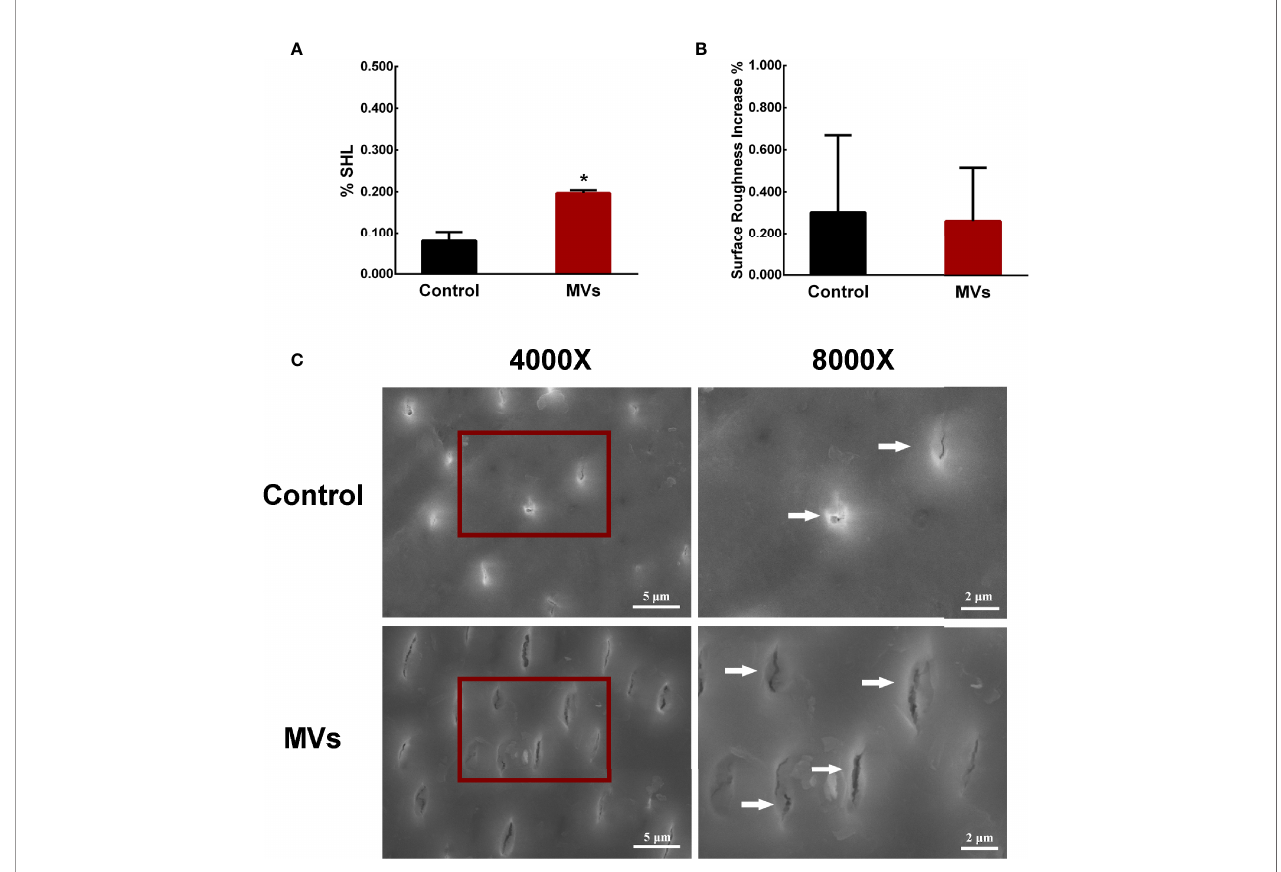
FIGURE 2 | S. mutans MVs promote C. albicans bio fi lm formation to induce bovine dentin demineralization. (A) Dentine surface hardness loss (%SHL) (n = 8). (B) Dentine surface roughness increase (n = 8). (C) SEM images of dentin surfaces. Each fi eld of view was magni fi ed 4,000× and 8,000×. The red boxes indicate the magni fi ed viewing area. The white arrows show the exposed dentin tubules. The data are presented as the means ± SD, *P < 0.05 vs control